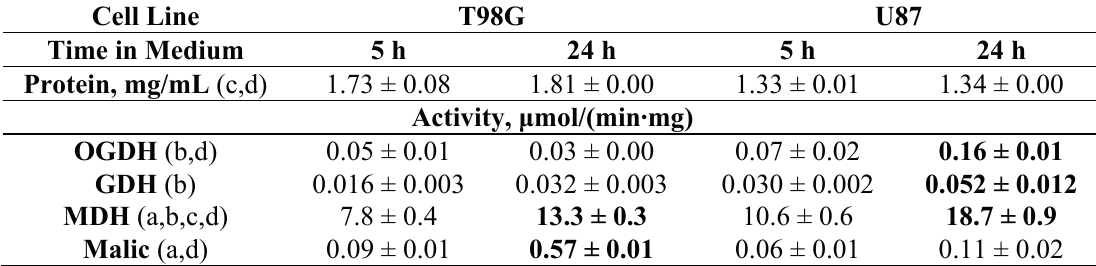
Table 1. Total protein and enzyme activities in T98G and U87 cells during incubation in cell culture medium. The data are presented as mean ± SEM. Statistically significant differences ( p < 0.05) between 5 h and 24 h ( a —T98G 5 h vs. T98G 24 h; b —U87 5 h vs. U87 24 h) or between cells at the same growth time ( c —T98G 5 h vs. U87 5 h; d —T98G 24 h vs. U87 24